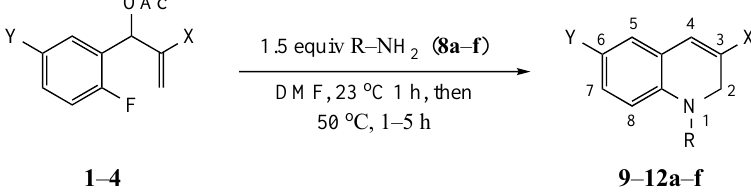
Table 1. Synthesis of 3,6-disubstituted 1-alkyl/phenyl-1,2-dihydroquinolines.